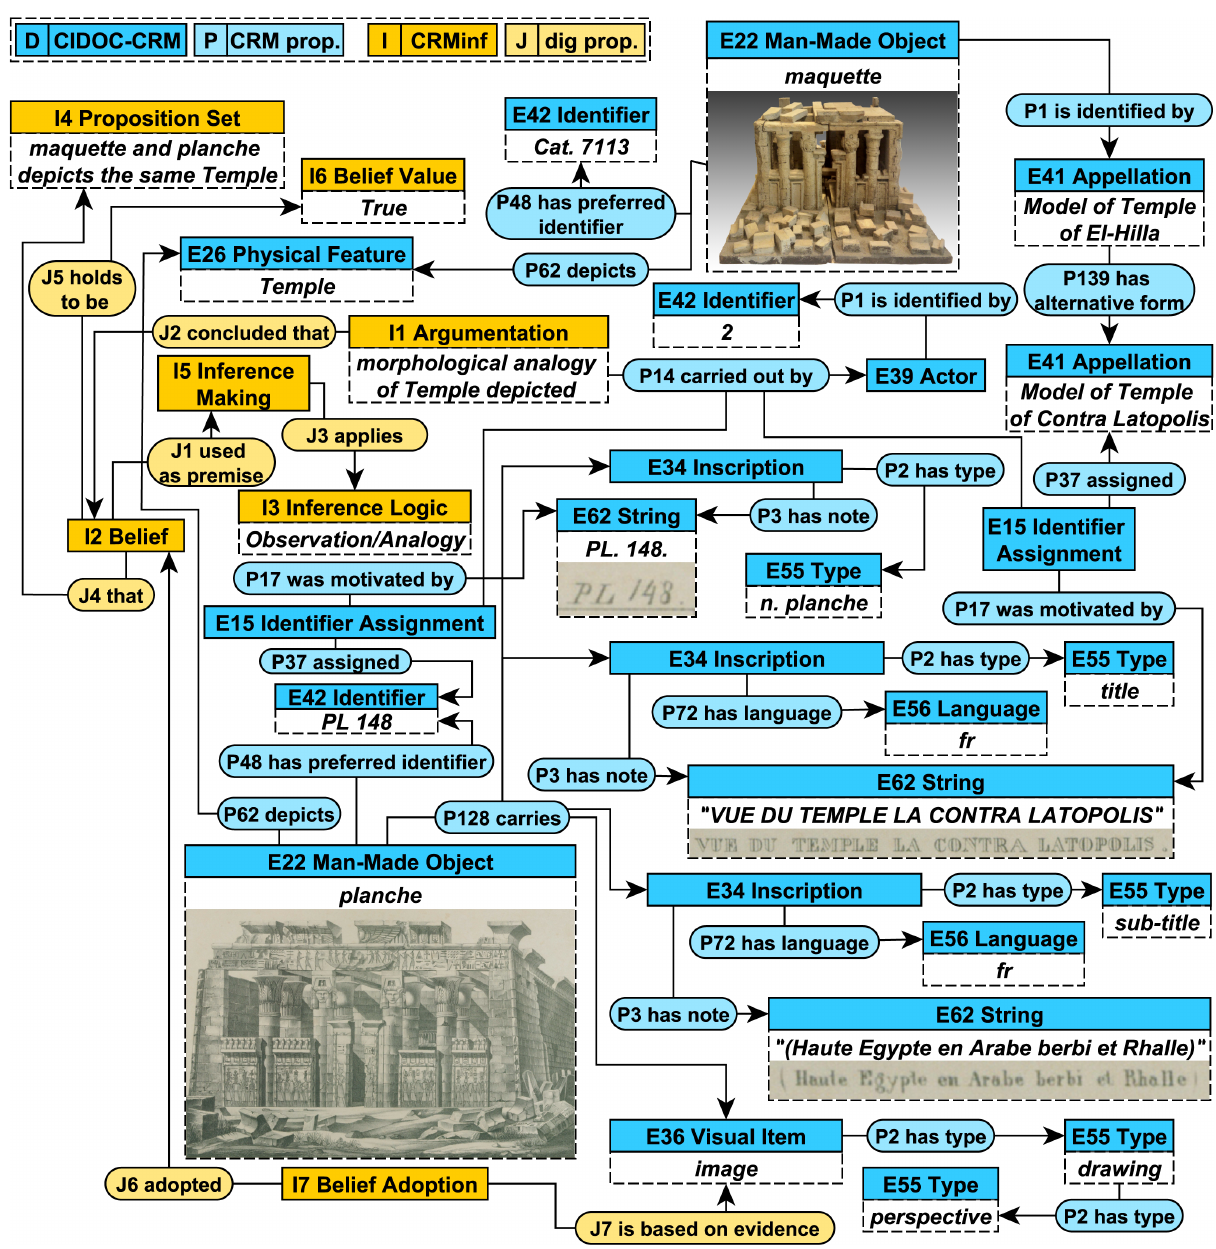
Figure 8. Data modelling of the “maquette and planche association” based on archival